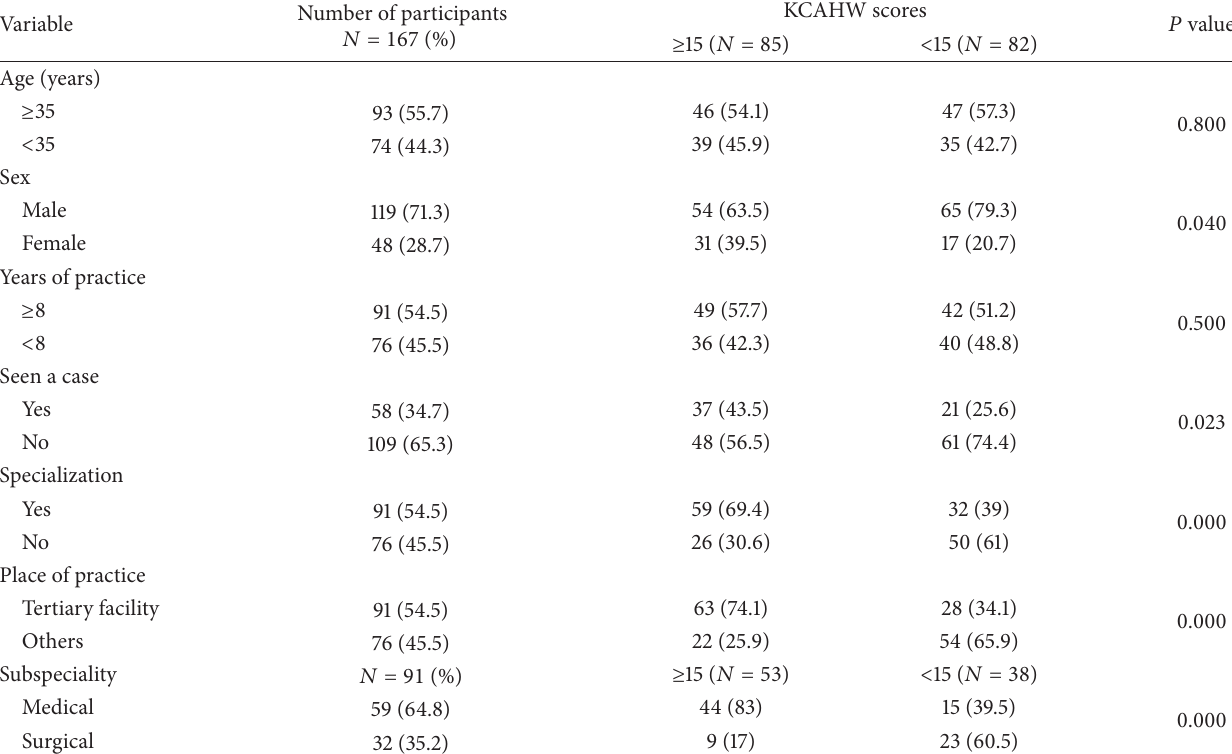
Table 4: Relationship between participants and KCAHW scores.